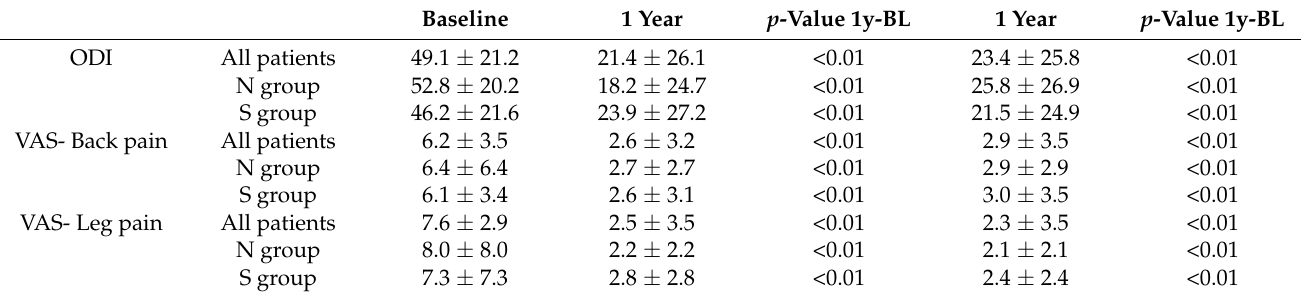
Figure 3. Changes in visual analogue scale for leg pain in each group throughout the follow-up period. Table 3. Changes in the Oswenstry Disability Index (ODI) on the visual analogue scale (VAS) for back pain within each group throughout the follow-up period.